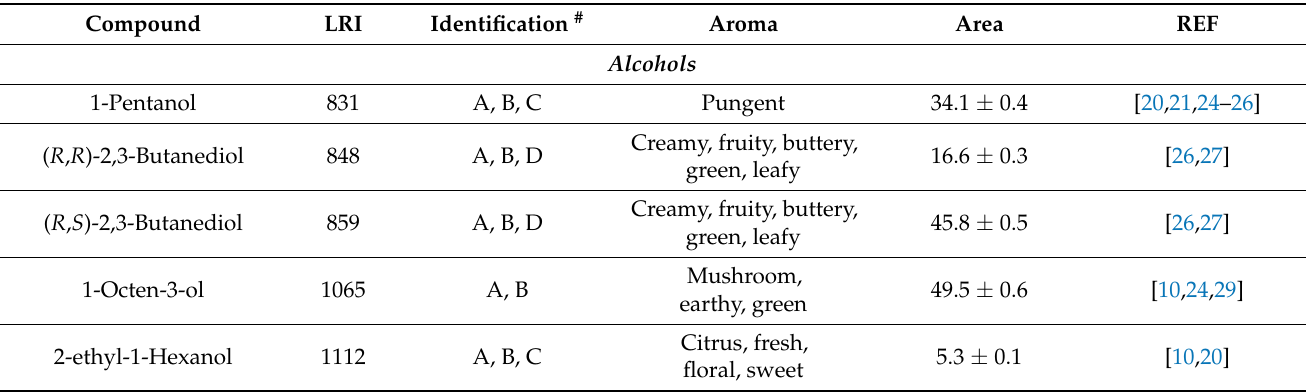
Table 3. VOCs of the bleached melon pomace after 24 months of storage (M_B_O_t 24 )